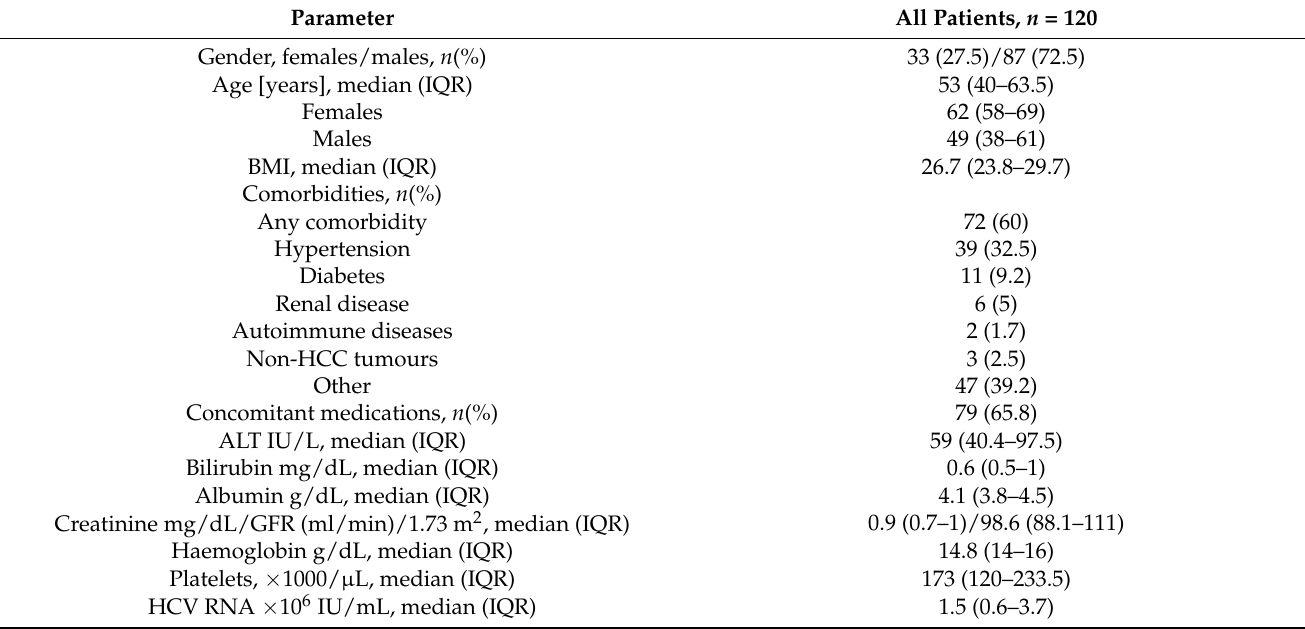
Table 2. Baseline characteristics.